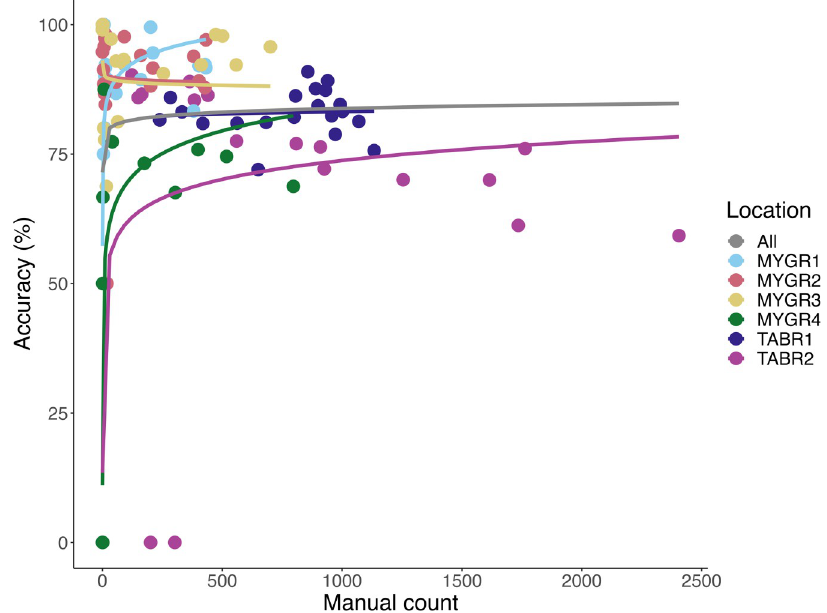
Fig 3. Performance curves based on number of bats in each video segment. At low numbers of bats ( < 50 bats per 30 second segment), the software demonstrated variable accuracy. At medium numbers of bats (between 50 and 800 bats per 30 second segment), the software performance remained stable, with location affecting overall accuracy. At high numbers of bats ( > 800 per 30 second segment), performance began to decline as bats overlapped.